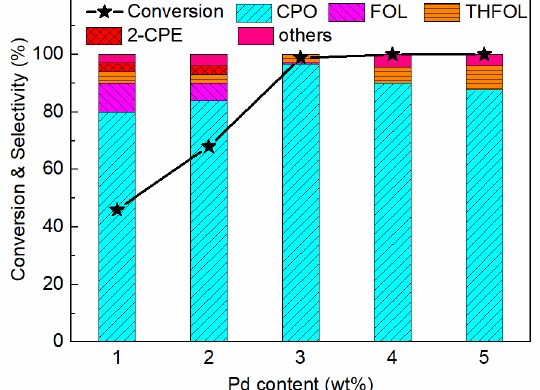
Figure 6. Effect of Pd loading on conversion and product selectivity in hydrogenative ring-rear- rangement of FAL over Pd/UiO-66-NO 2 - 7 . Reaction conditions: catalyst (5.0 mg), H 2 O (9.9 g), 150 °C, 1.0 MPa H 2 pressure, 5